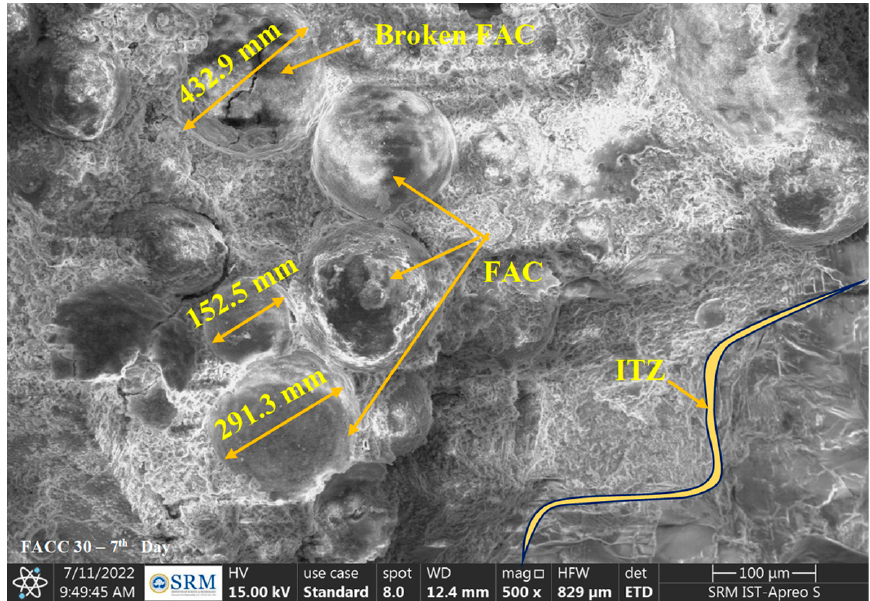
Figure 14. Macroscopic view of ITZ view in FACC. Table 8. UPV and RN Values of CC and